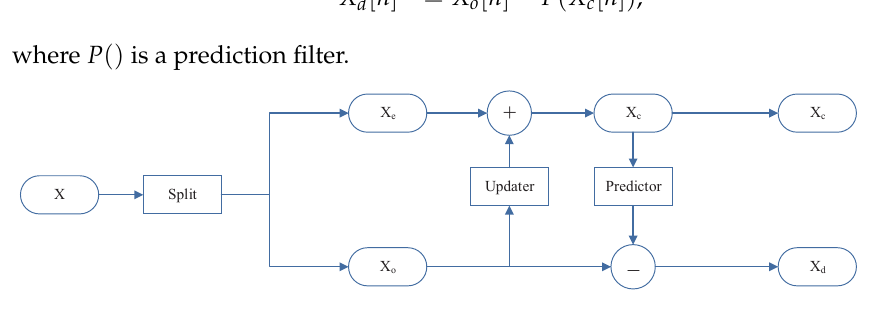
Figure 1. The flowchart of the lifting